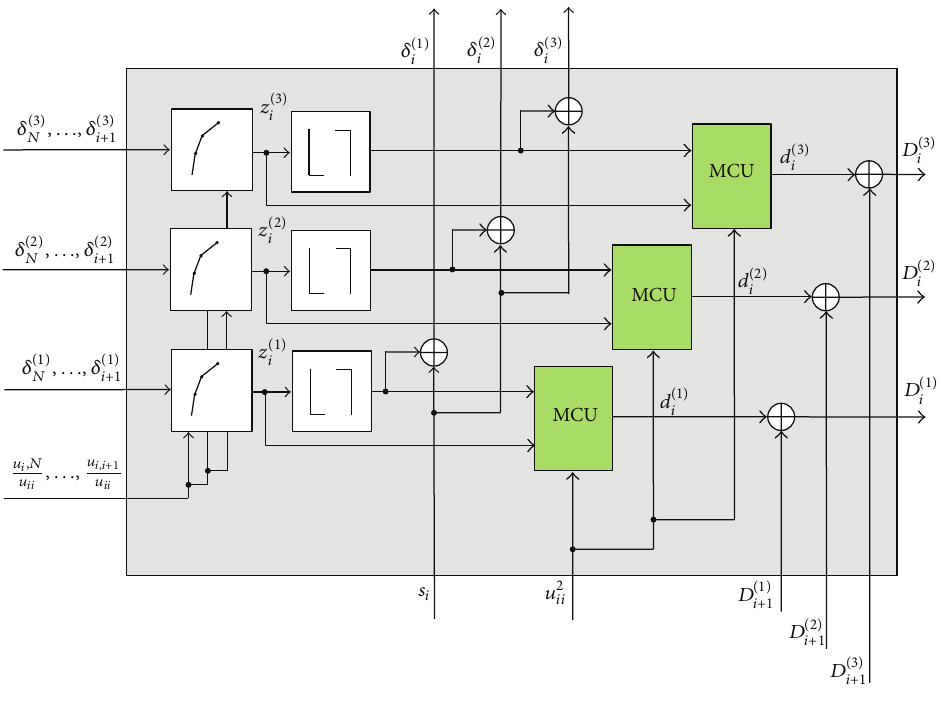
Figure 5: Block diagram of the FSE